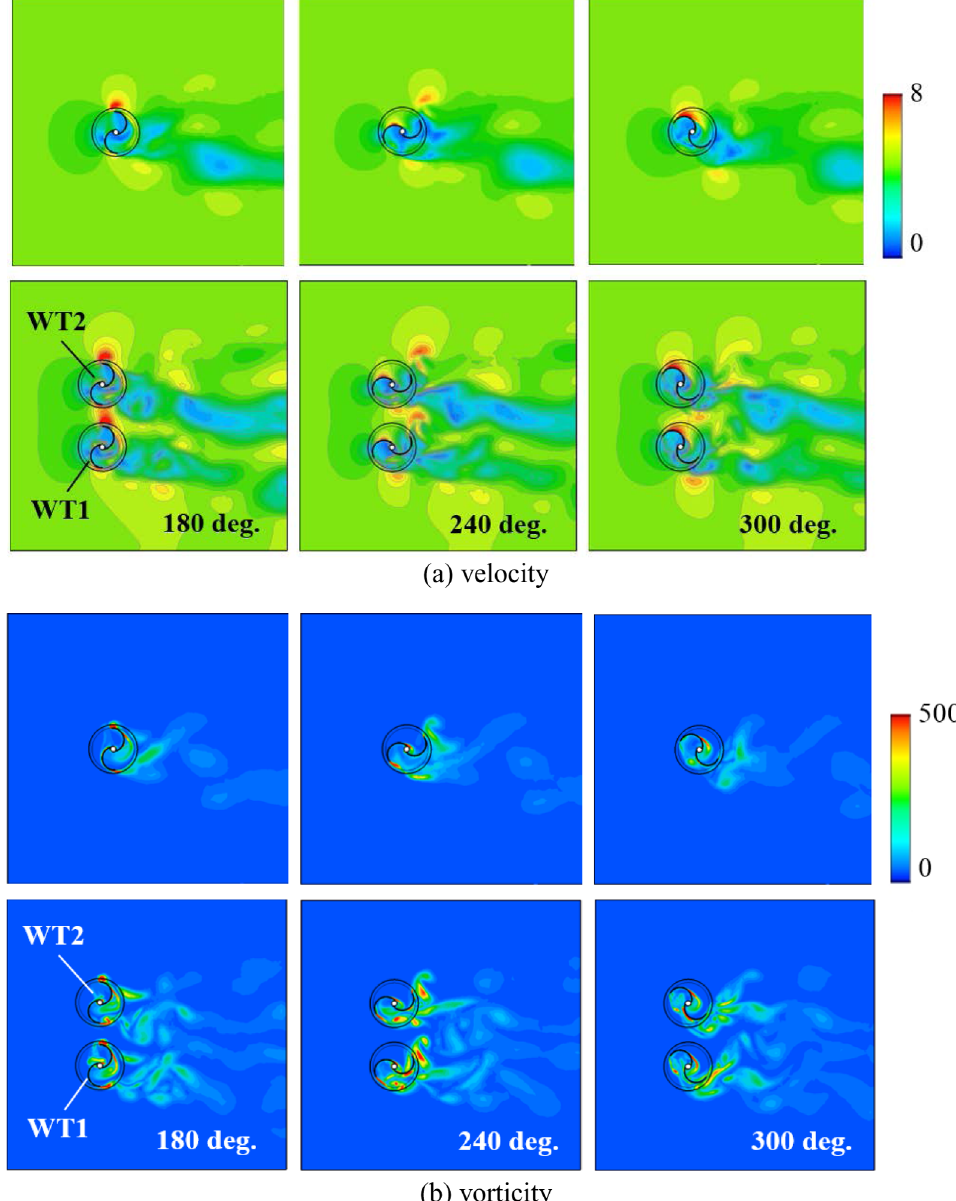
Fig. 7. Velocity and vorticity with respect to azimuthal angle for l =0.6. (a) Velocity. (b)